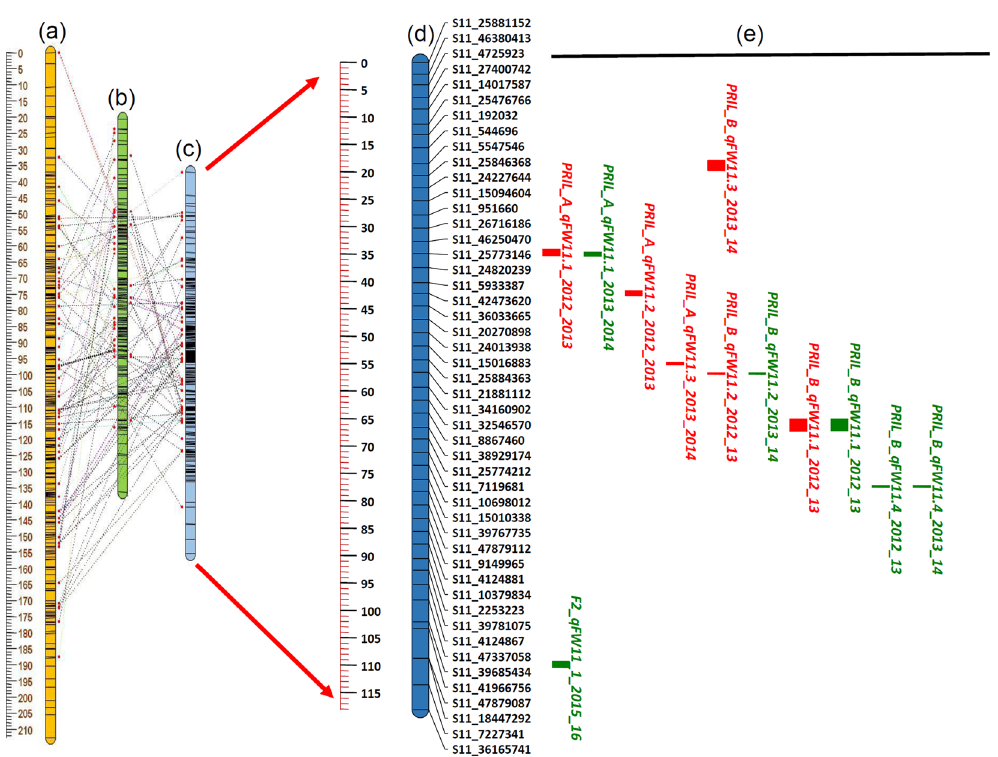
Figure 4. Iterative map of CcLG11 and distribution of QTLs associated with FW resistance among three mapping populations. The Iterative map of CcLG11 was created using Biomercator version 4.2 using the genetic information of all three linkage maps ( a ) PRIl_A, ( b ) PRIL_B, and ( c ) F 2 . Based on the presence of common markers (connected with dotted arrow) among three populations a genetic linkage map ( d ) of ~118 cM was developed. Marker names are indicated to the right of the linkage groups, and the map distances in cM are shown to the left of the linkage groups. ( e ) A total of 13 QTLs identified for FW resistance at Patancheru and Gulbarga locations were represented as a vertical bar in green and red colors, respectively. A QTL is named as qFWY . a -YYYY_YY, with ‘FW’ being the trait abbreviation fusarium wilt, ‘Y’ the number of the linkage group, ‘a’ the letter to specify different QTLs for the same trait in one linkage group (CcLG), and ‘YYYY_YY’ the year in which the trait was phenotyped. To represent the QTLs of different experiments, PRIL_A, PRIL_B and F 2 were added as prefix before the name of the